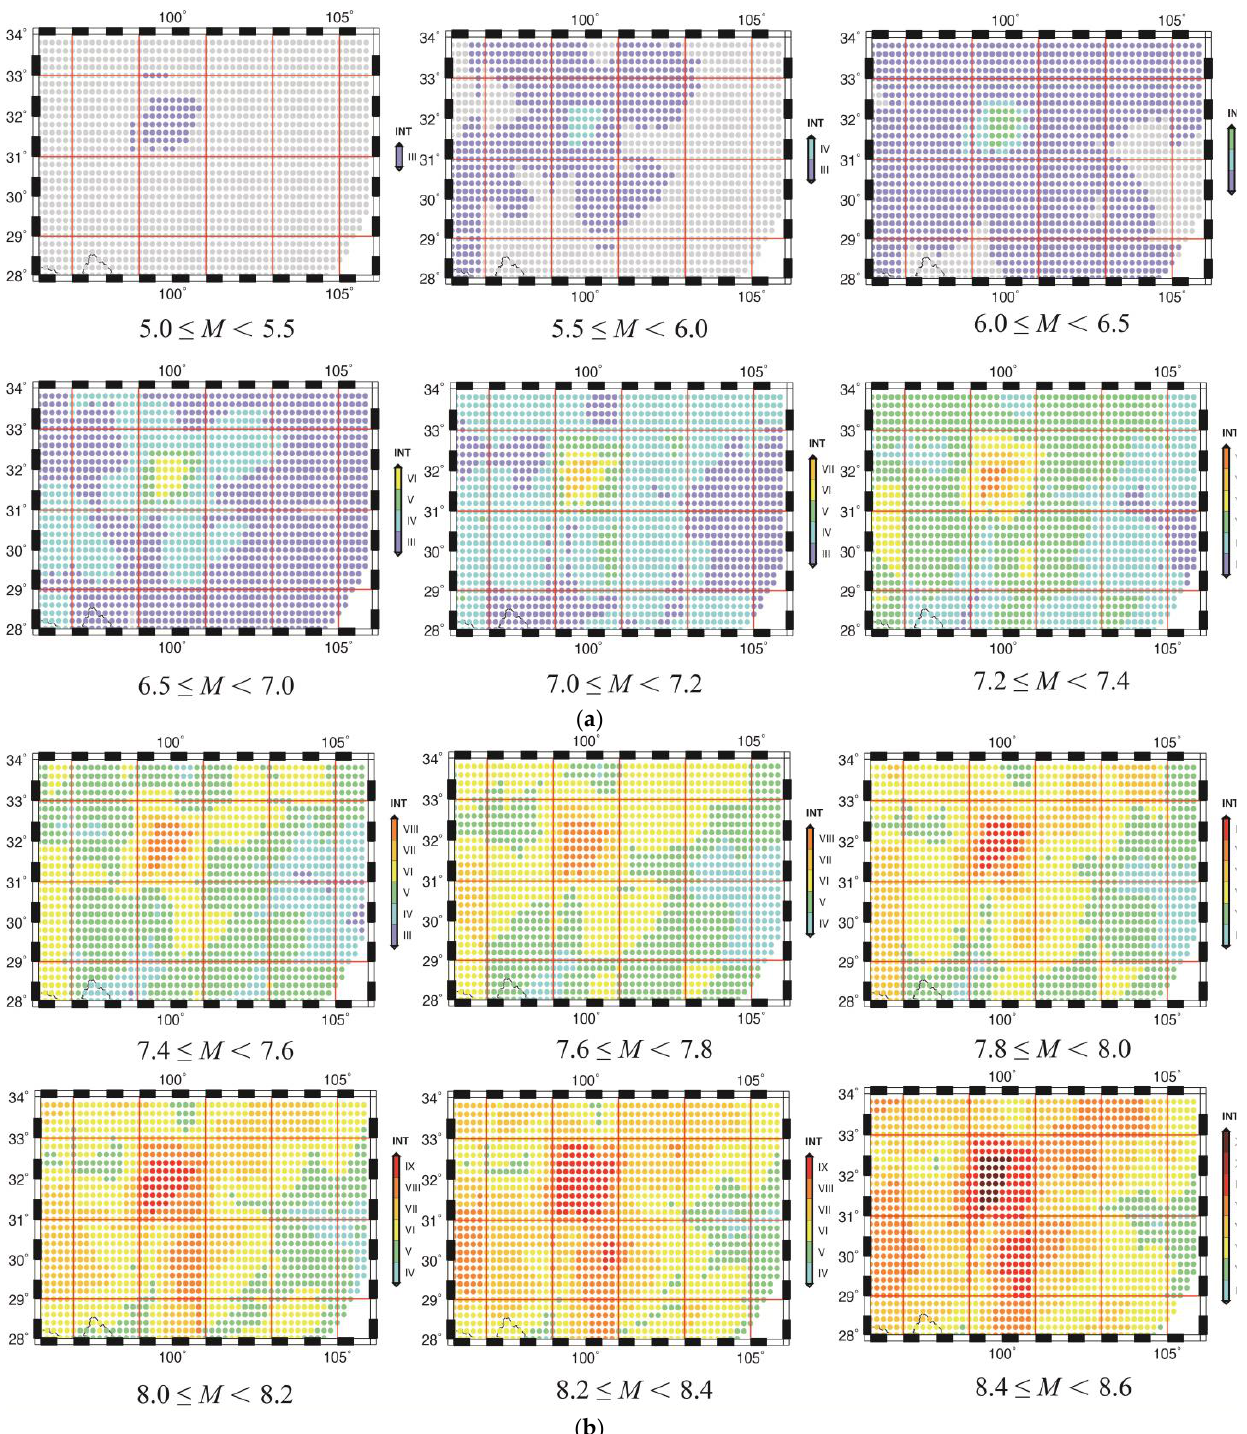
Figure 9. The sources to be used in the 12 scenario computations, with a different value of magnitude for each cellular earthquake source. For each scenario computation, the value of magnitude is defined as the lower limit of the correspond- ing magnitude, e.g., the adopted magnitude for computing MMI map i s 5.0 for the 5.0 ≤ M < 5.5 class.